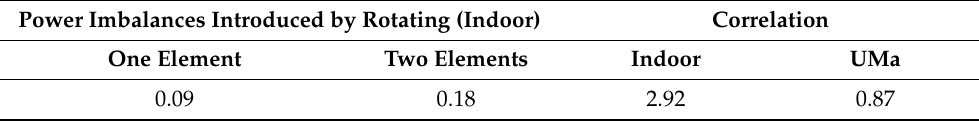
Table 3. RMSEs (dB) between simulated and theoretical SM efficiencies with the QuaDRiGa channel model.